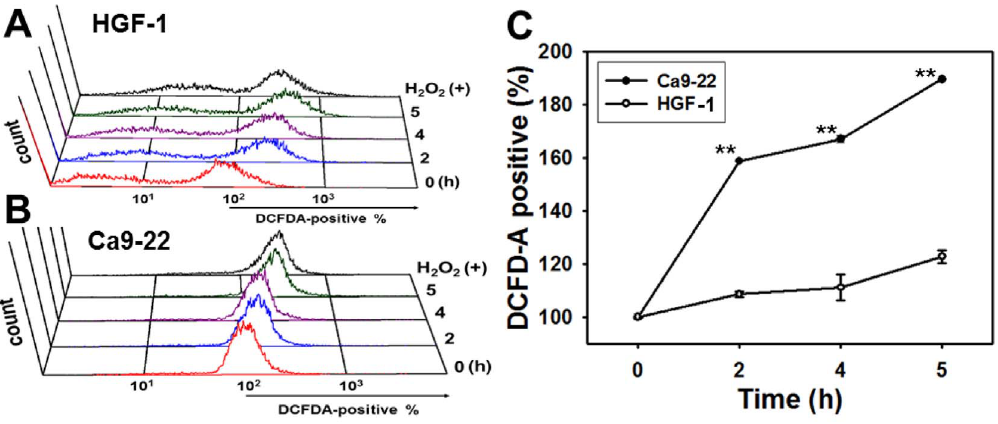
Figure 2. Generation of ROS differed between oral cancer Ca9-22 cells and normal oral HGF-1 cells after 4 b HWE treatment. Cells were administered a vehicle and 3.6 m g/ml of 4 b HWE for varying time intervals (0 to 5 h). To measure ROS change, 200 m M H 2 O 2 was used as a positive control. (A, B) Representative flow cytometry-based ROS profiles for 4 b HWE-treated cells. (C) Quantification analysis of ROS intensity in terms of DCFD-A positivity (%). The asterisks indicate significant differences between two cell lines after treatment with similar 4 b HWE concentrations ( t - test, P , 0.0001**).